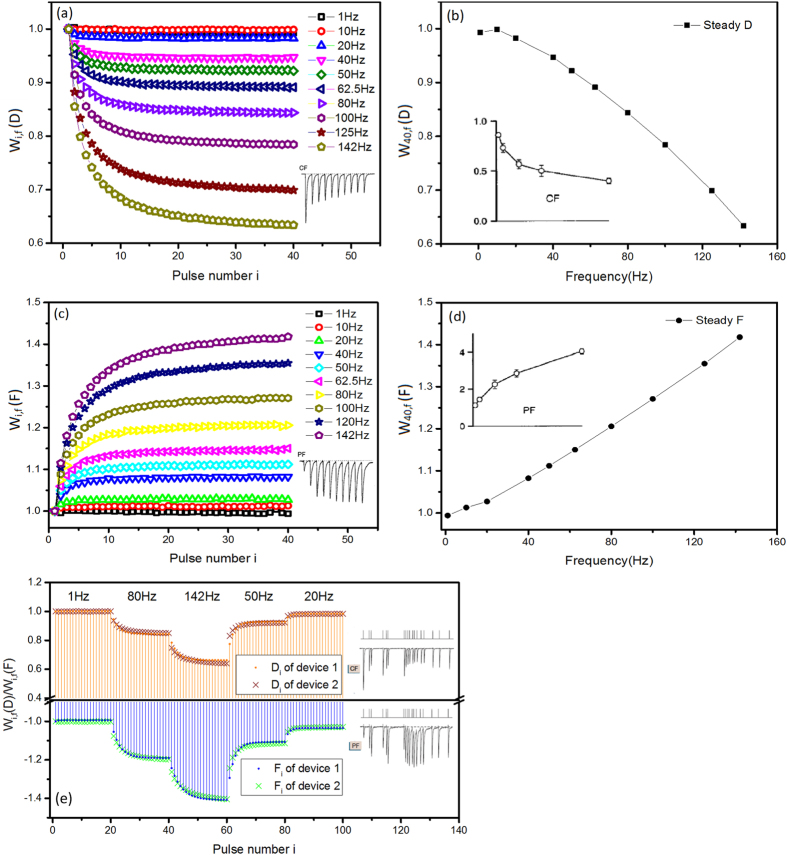
Weight modifications of Di and Fi sequences under the pulse mode.(a) The weight modifications of Di
vs pulse number at various frequencies: Wi,f (D) = I(Di,f)/I(D1,f). Inset shows EPSCs of climbing fibre (CF) under HFS, which decreases with increasing pulse number27. (b) The weight modifications of Divs. frequency after a train of 40 pulses is loaded; inset shows those of CF:27
W,n,f
(D) = I(Dn,f)/I(D1,f), n = 40. (c) The weight modifications of Fivs. pulse number at various frequencies: Wi,f (F) = I(Fi,f)/I(F1,f). Inset shows EPSCs of parallel fibre (PF) under HFS27. (d) Weight modifications of Fivs. frequency after a train of 40 pulses is loaded; the inset shows those of PF:27Wn,f (F) = I(Fn,f)/I(F1,f), n = 40. (e) A set of Di and Fi generated by a pulse package containing several frequencies. The results of the two different single devices were tested during the same testing period and showed similar weight modification levels. Insets show EPSC variations of CF and PF in a pulse package containing several frequencies16.